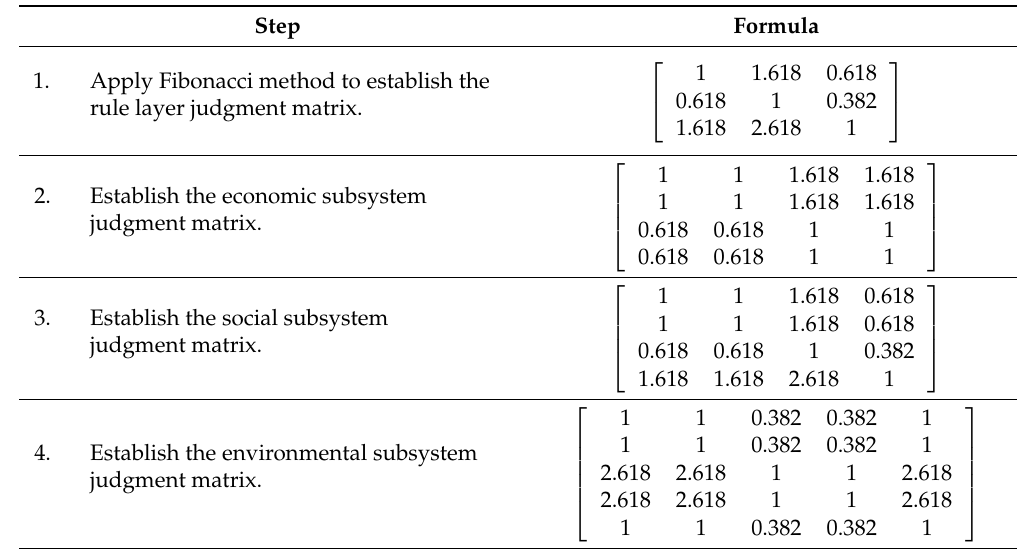
Table A1. The step and formula of